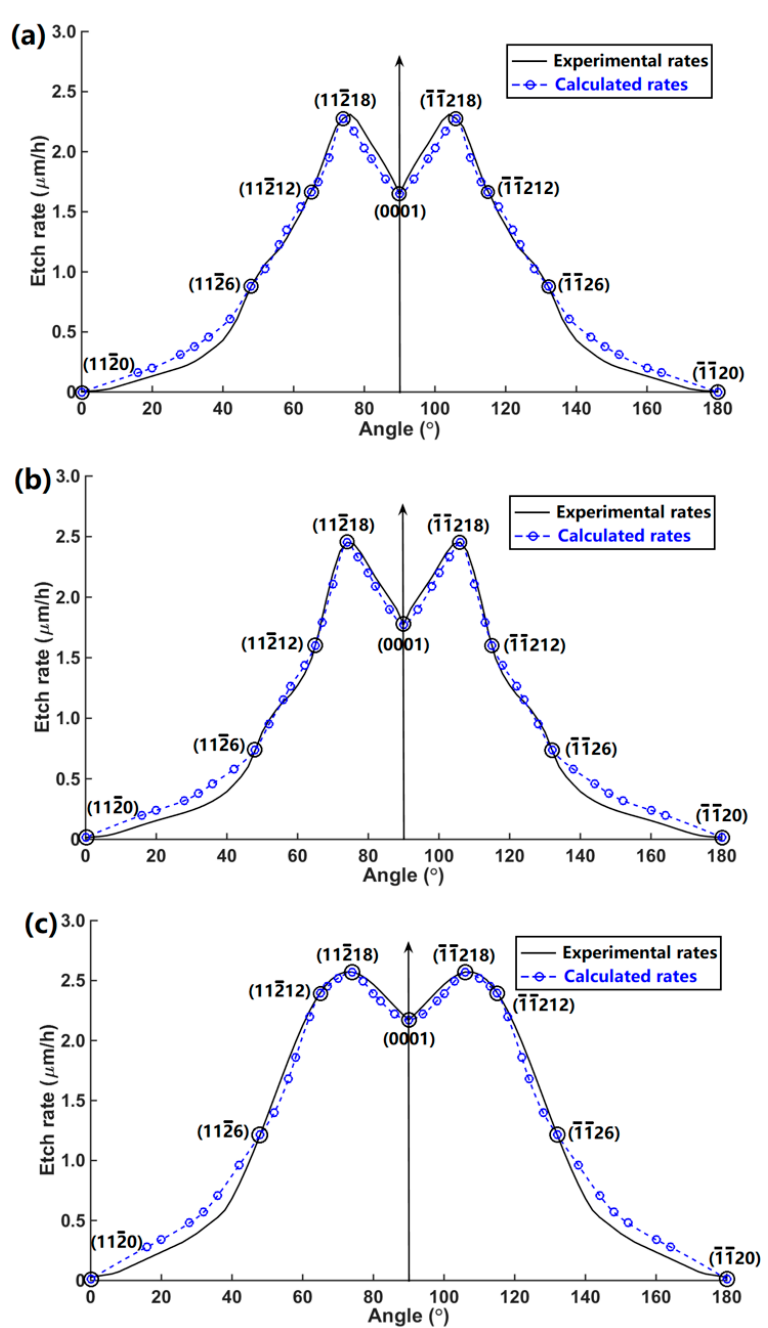
Figure 12. The comparisons between calculated and experimental rates in the < − 1 1 0 0> crystal zone in the three different concentration conditions: ( a ) 236 °C, H 2 SO 4 :H 3 PO 4 = 1:1; ( b ) 236 °C, zone in the three different concentration conditions: ( a ) 236 ◦ C, H 2 SO 4 :H 3 PO 4 = 1:1; ( b ) 236 ◦ C, H 2 SO 4 :H 3 PO 4 = 3:1; ( c ) 236 °C, H 2 SO 4 :H 3 PO 4 = 6:1. H 2 SO 4 :H 3 PO 4 = 3:1; ( c ) 236 ◦ C, H 2 SO 4 :H 3 PO 4 =